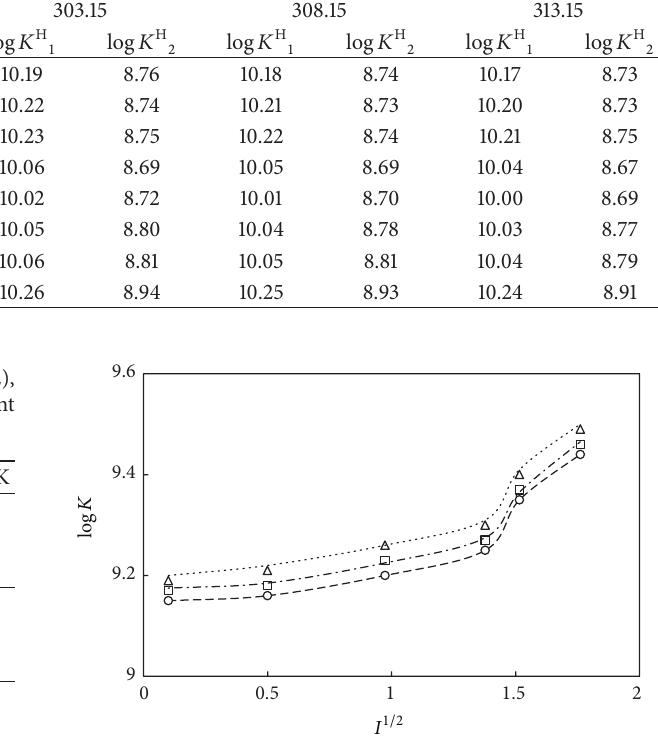
Figure 1: Dependence of the protonation constant on ionic strength in KCl, for 1-naphthol: the experimental values are 293.15 K ( 󳵻 ), 303.15 K ( ◻ ), and 313.15 K ( I ) and the model values are expressed in dotted